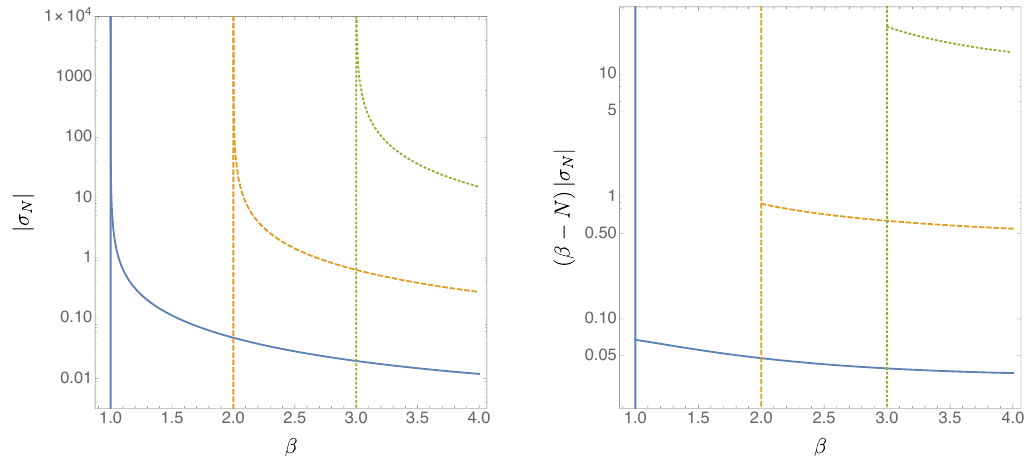
Figure 8 . Left panel: j (cid:27) N j computed for several values of N . Right panel: j ( (cid:12) (cid:0) N ) (cid:27) N j as a function of (cid:12) computed for several values of N . In both panels, the solid blue curve corresponds to N = 1, the orange dashed line to N = 2 and the dotted green line to N = 3. Finally, the vertical lines represent (cid:12) = 1 ; 2 ; 3, from left to right. In all cases we (cid:12)xed (cid:11) = 2 (cid:25)